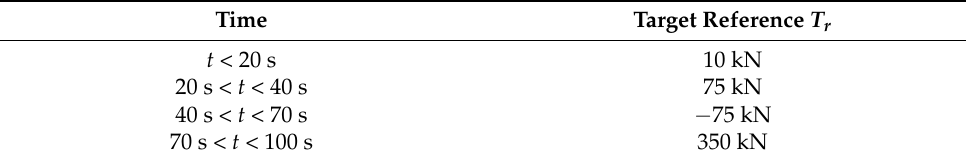
Table 4. Thrust reference T r